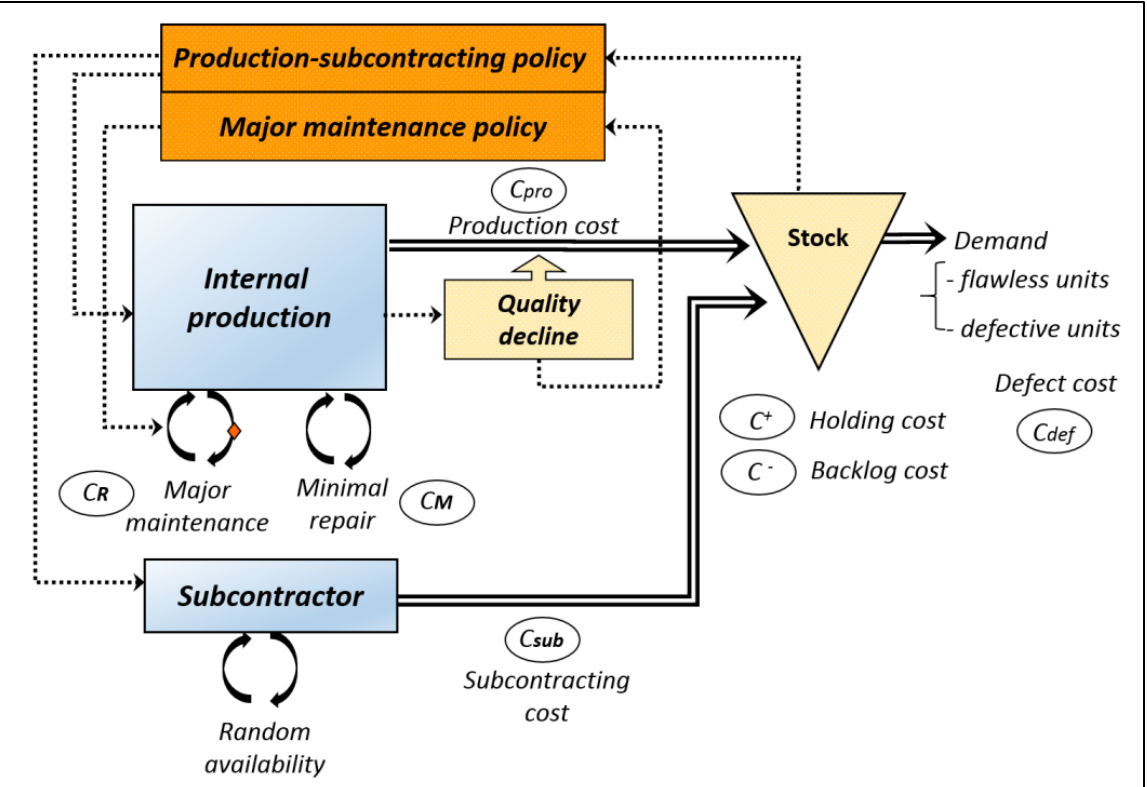
Figure 1. Block diagram of the production system.